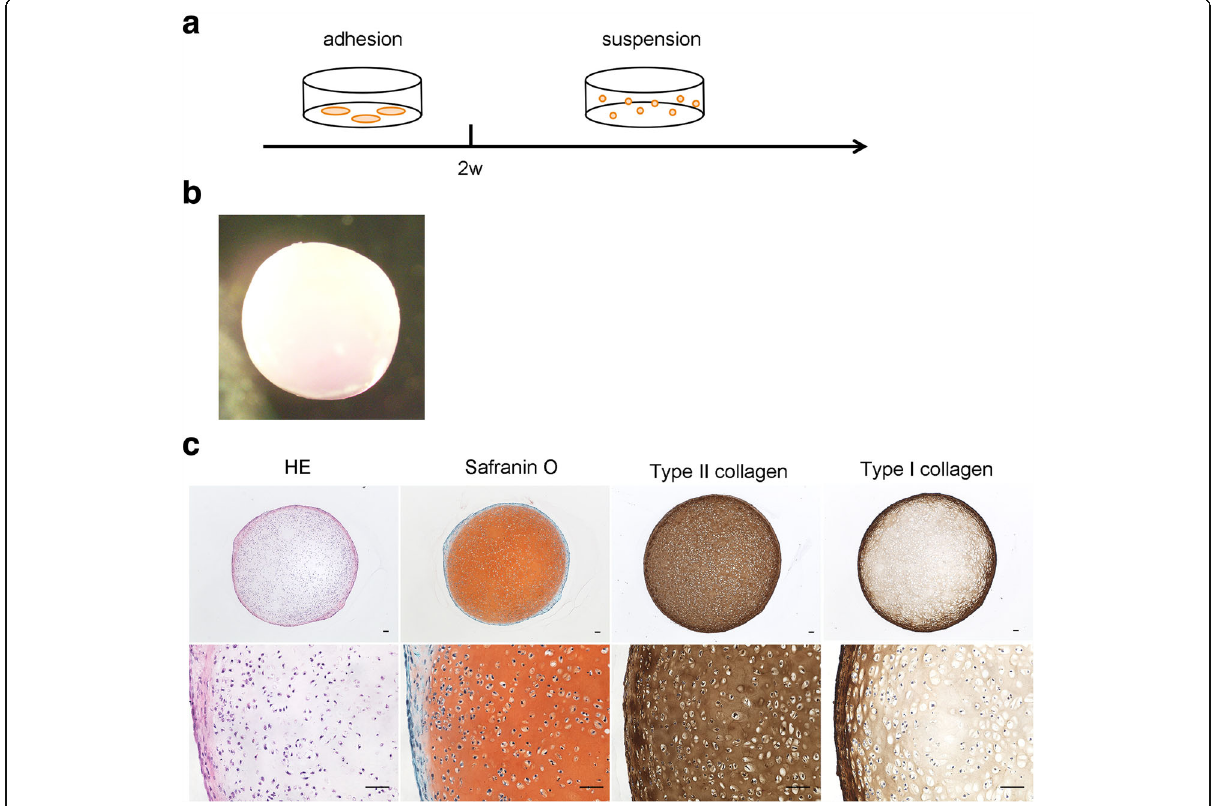
Fig. 1 Generation of cartilaginous particles from hiPSCs. a Scheme of the chondrogenic differentiation of hiPSCs. b Image of a hiPSC-derived cartilaginous particle at 12 weeks. c Histological analysis of the hiPSC-derived cartilaginous particle at 12 weeks. Semiserial sections were stained with hematoxylin-eosin and safranin O-fast green-iron hematoxylin and immunostained with anti-type II collagen antibodies and anti-type I collagen antibodies. Bars, 50 μ